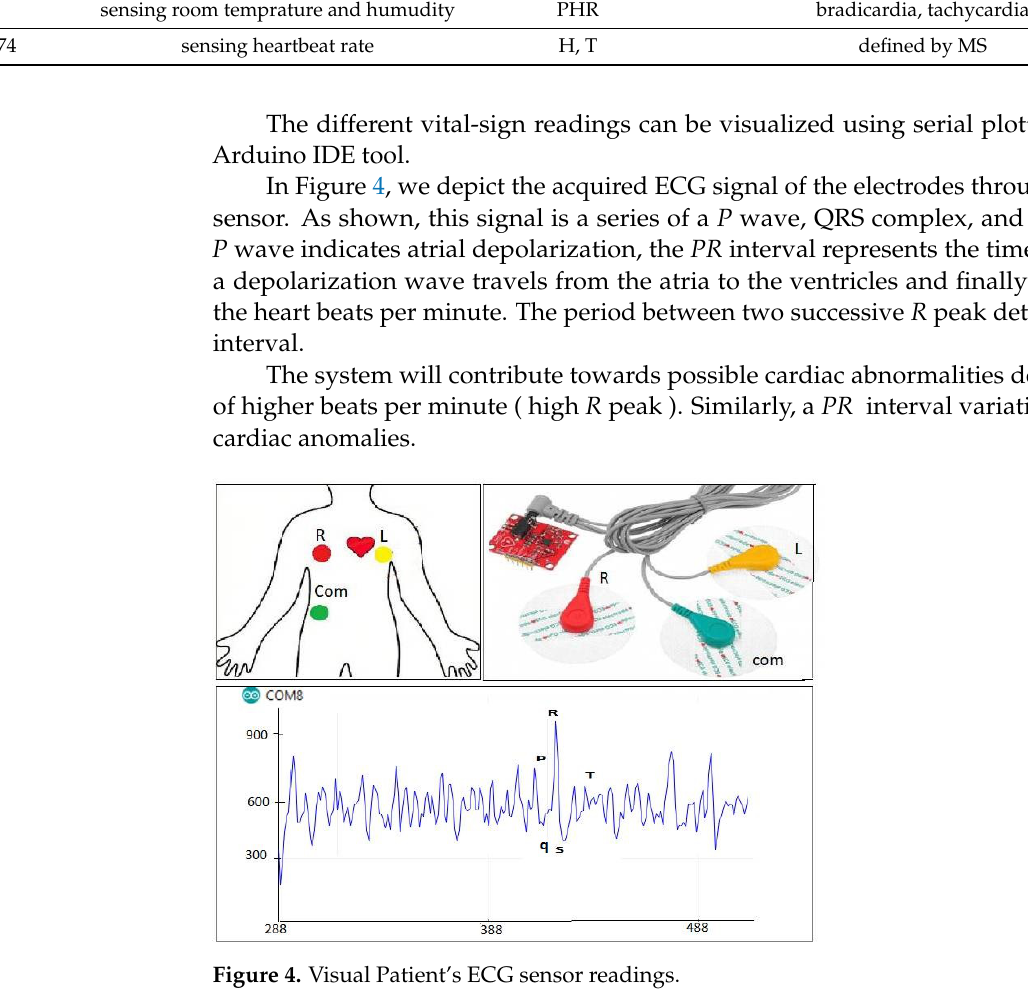
Figure 4. Visual Patient’s ECG sensor